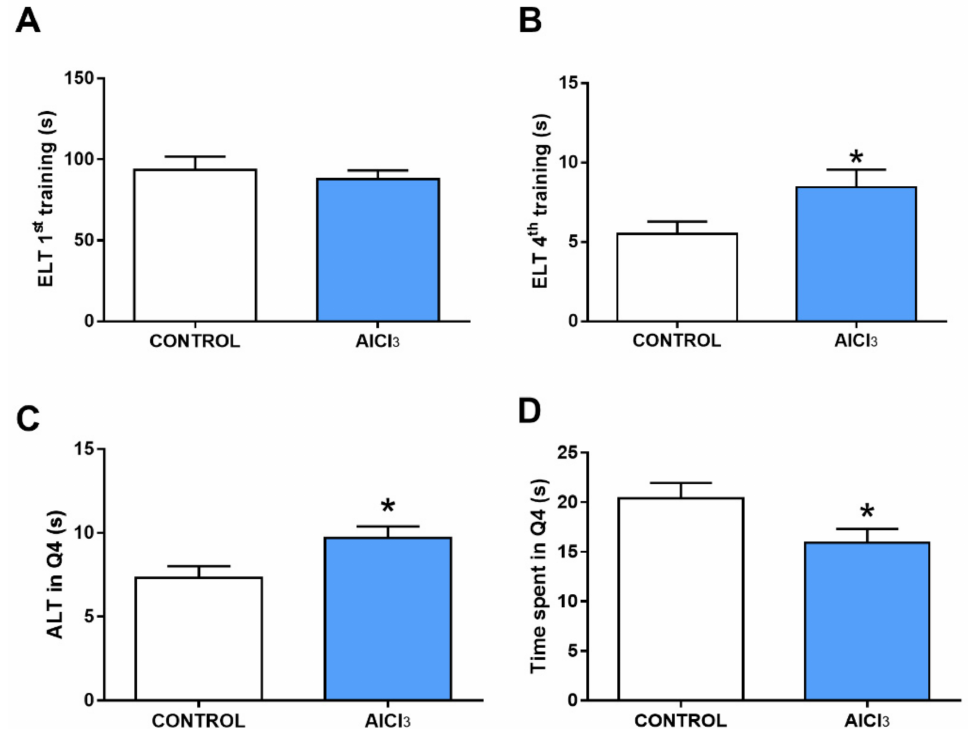
Figure 4. Aluminum exposure is associated with increased learning deficiency and spatial memory in rats. In ( A ) and ( B ) Escape latency time (ELT) first and fourth training in seconds. ( C ) Latency to arrive (ALT) in the target quadrant (Q4) and ( D ) time spent in target (s), respectively. Results are expressed as mean ± standard error of the mean. * p < 0.05, Student’s t -test, 12 animals per